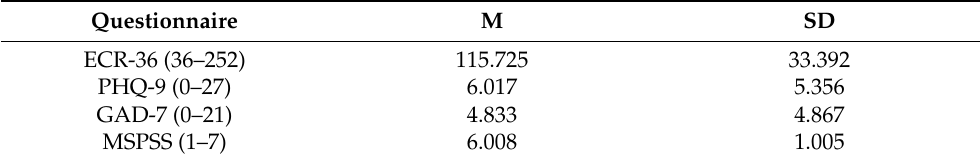
Table 1. Descriptive statistics of psychological